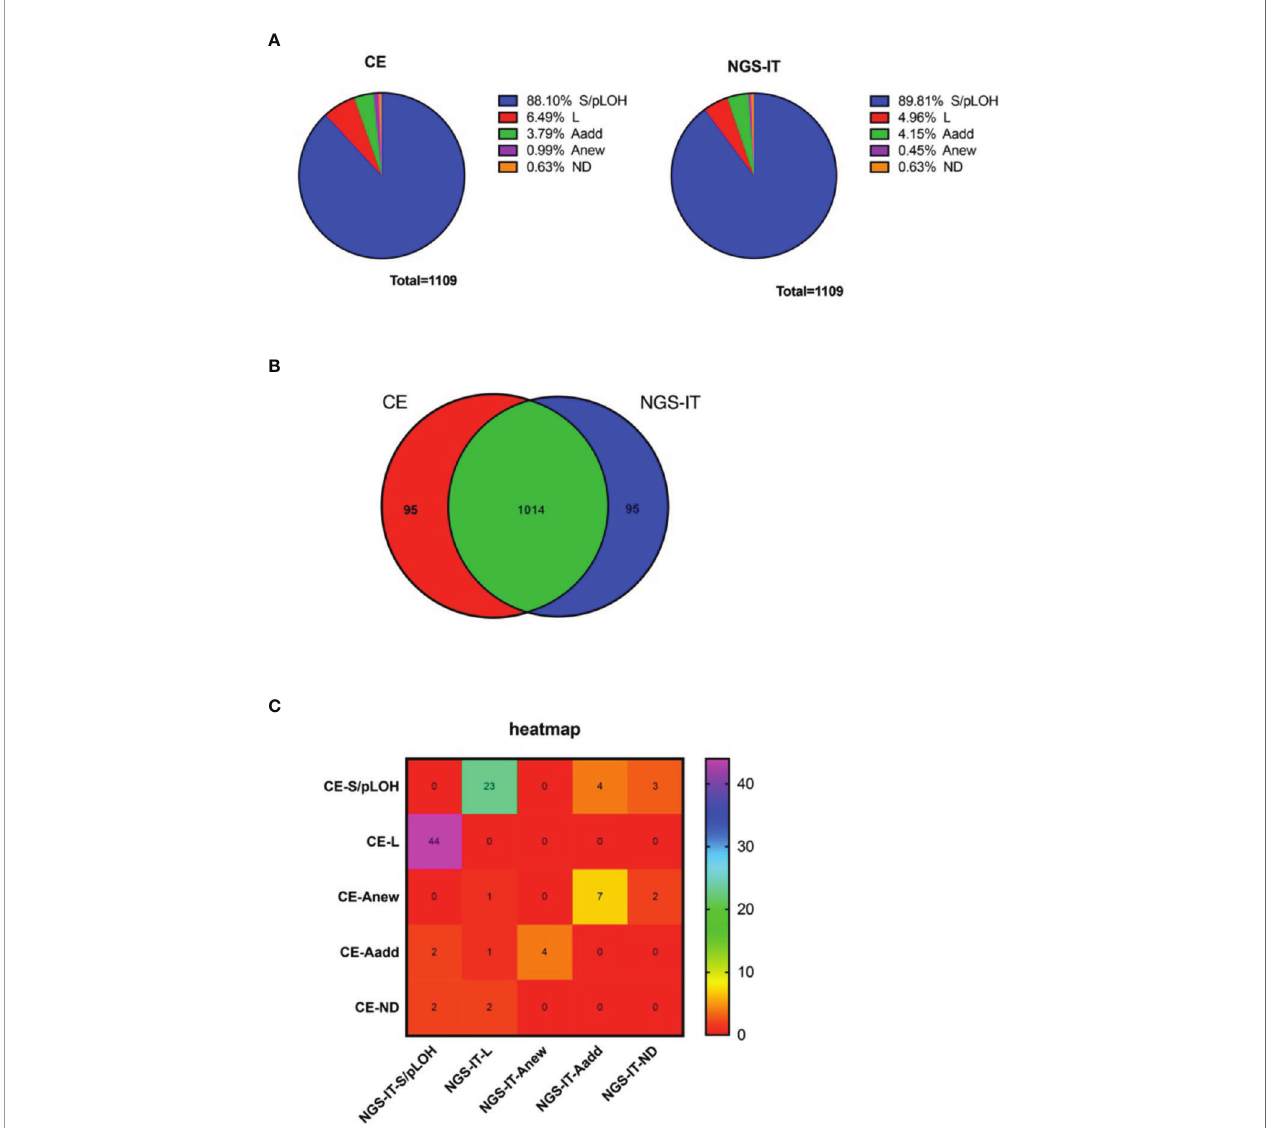
FIGURE 1 | The classi fi cation of STR status with the CE and NGS platforms. (A) Distribution of the STR status resulted from two platforms. Left, CE; right, NGS-IT. (B) Venn diagram illustrating the overlap between the STR status that resulted from different platforms. (C) Heat map depicts the STR status between CE and NGS- IT. The rainbow color key represents the number of the loci. Purple color represents an increasing number of the loci, and red color indicates decreasing number of the loci. STR, short tandem repeat; CE, capillary electrophoresis; NGS, next-generation sequencing; NGS-IT, NGS interpretation